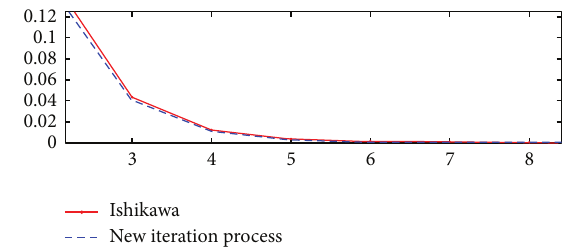
Figure 1: It shows the value functions found by successive steps of the Ishikawa and new iteration methods.